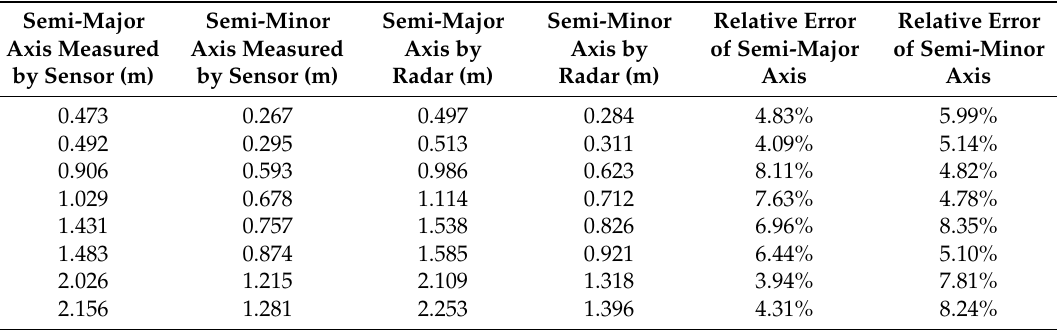
Figure 17. The displacement fitting at a single monitoring point: ( A ) Motion displacements of a single node; ( B ) Trajectory of a single point in a cycle (view from the Z-axis). Table 1. Experimental data of the elliptical motion. Table 1. Experimental data of the elliptical motion.